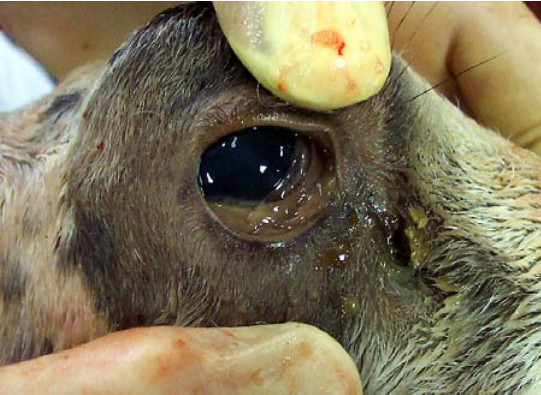
Figure 2. Brownish ocular mucosa due to the massive hemolysis caused by copper.